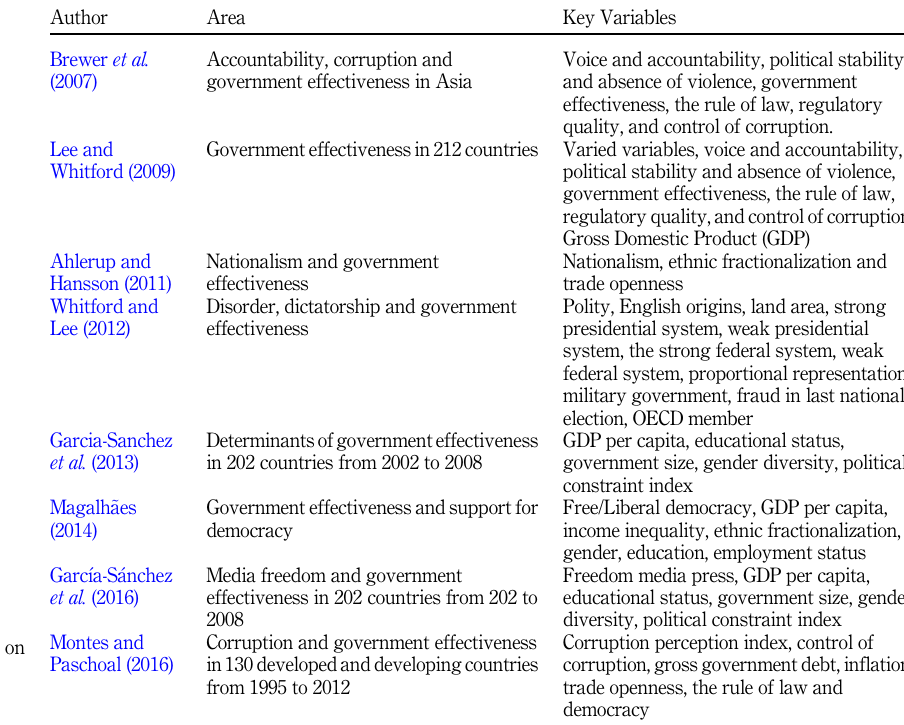
determinants of government